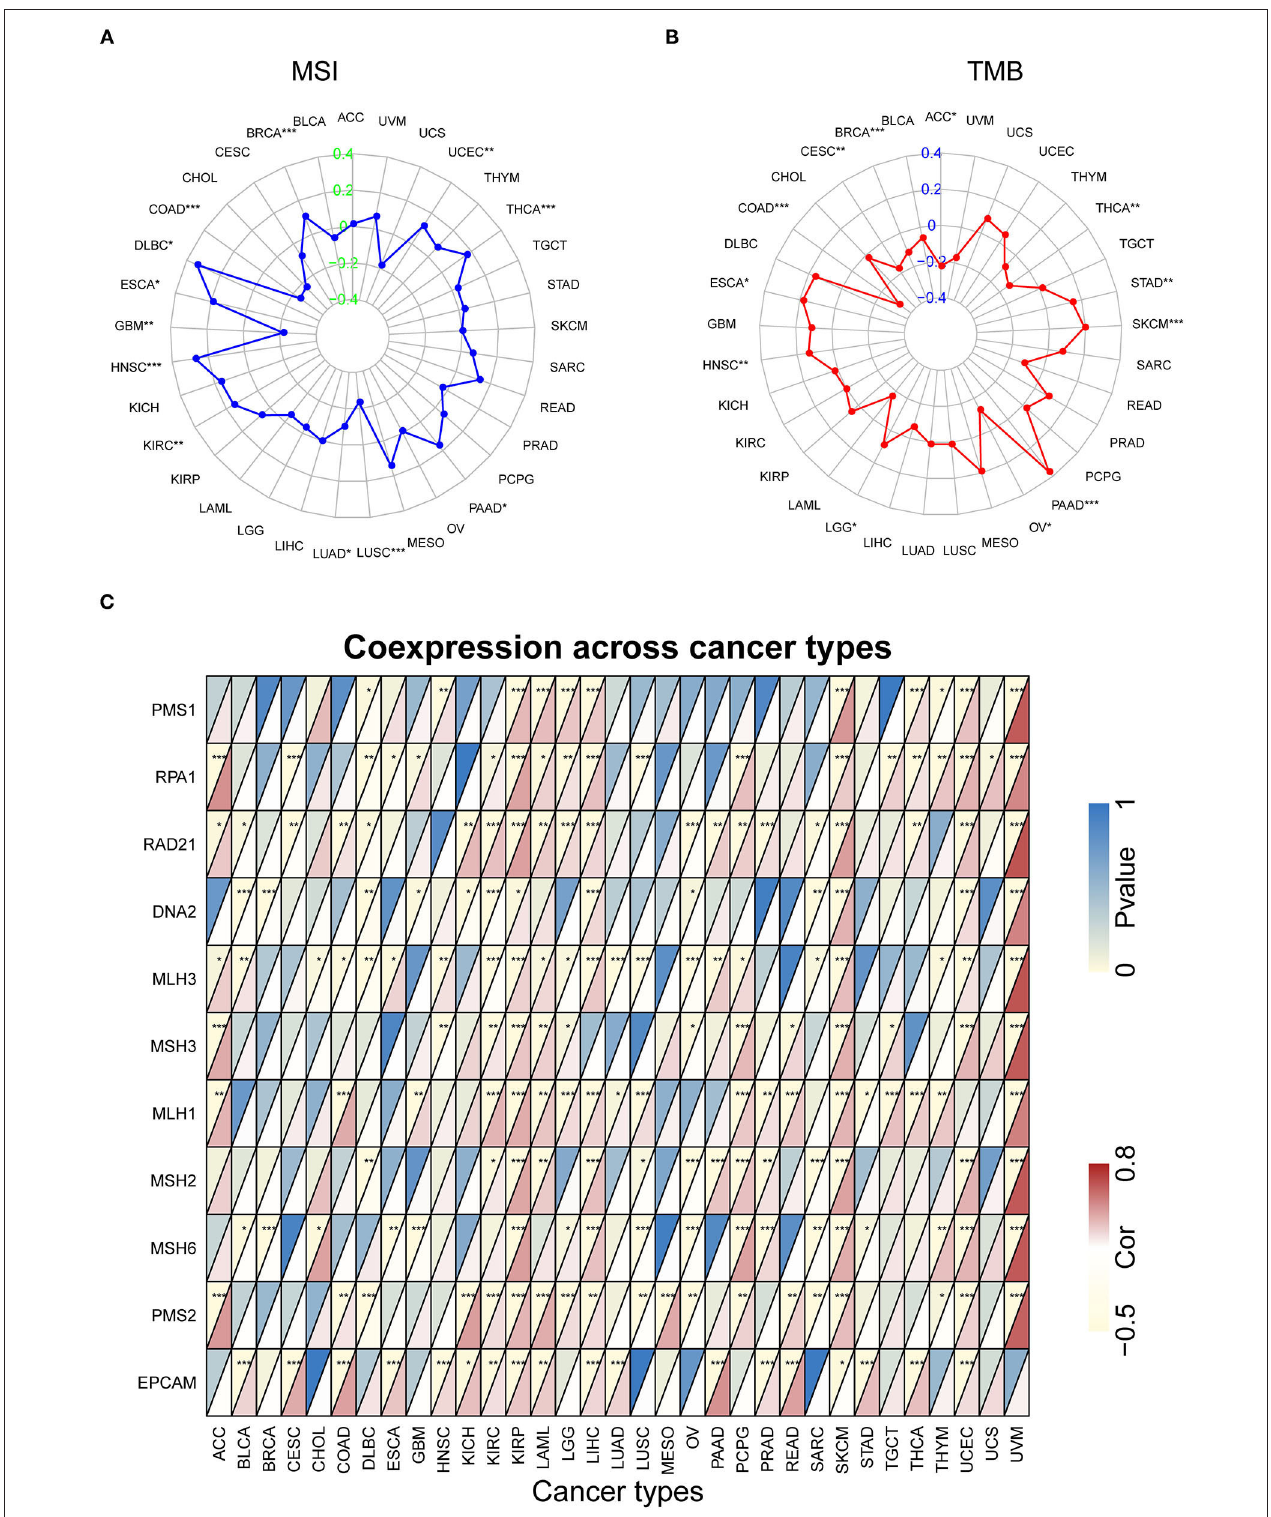
FIGURE 8 | The correlation of SRI expression with microsatellite instability (MSI), tumor mutational burden (TMB), and mismatch repair (MMR) genes. (A) Radar map of correlation between the SRI expression and MSI. (B) Radar map of correlation between the SRI expression and TMB. (C) A heatmap indicating the correlation between the SRI expression and MMR genes. For each pair, the top left triangle indicates the P -value, and the bottom right triangle indicates the correlation coefficient * P < 0.05, ** P < 0.01, and *** P < 0.001.